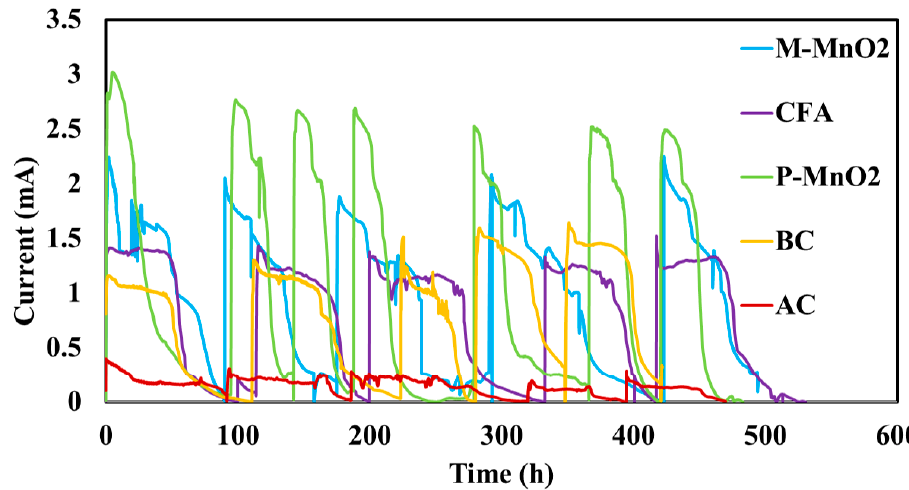
Figure 3. Current output during consecutive batch experiments of the five units with the different cathode assemblies (P-MnO 2 , M-MnO 2 , CFA, BC, AC) versus time.